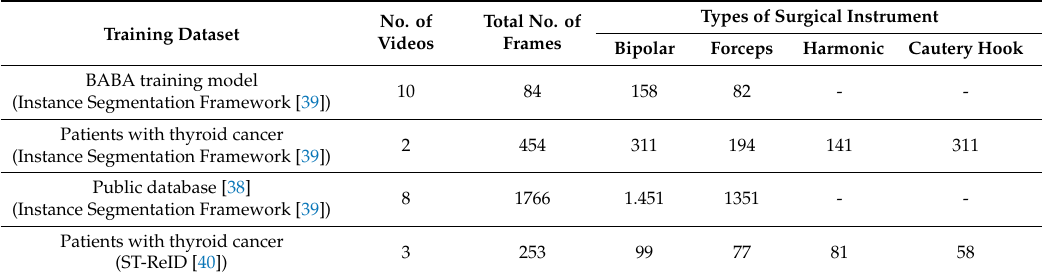
Table 1. Training datasets for the instance segmentation framework and spatial-temporal re-identification. Training